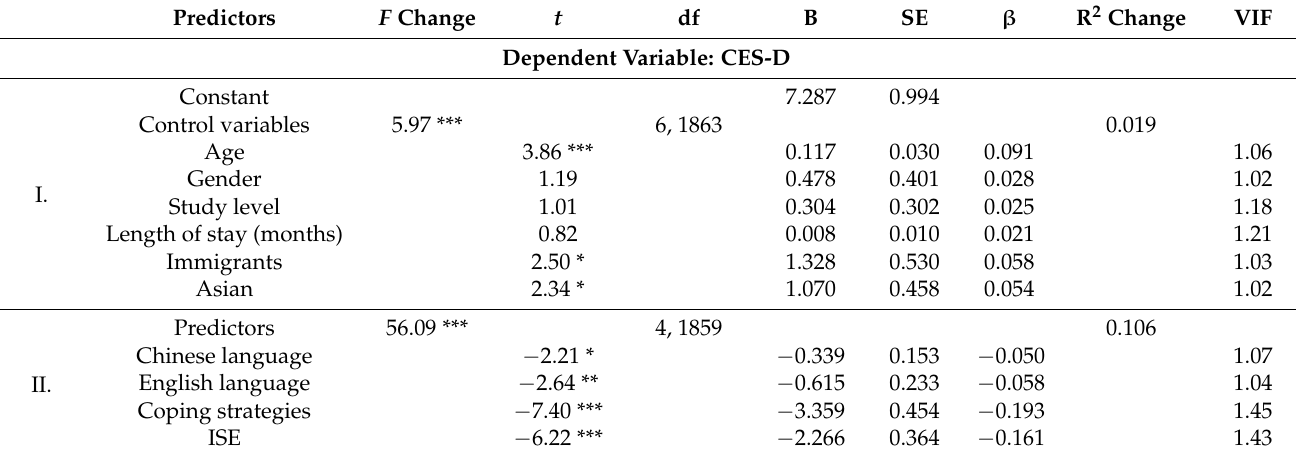
Table 4. Hierarchical multiple regression analysis of study-abroad-related depression.